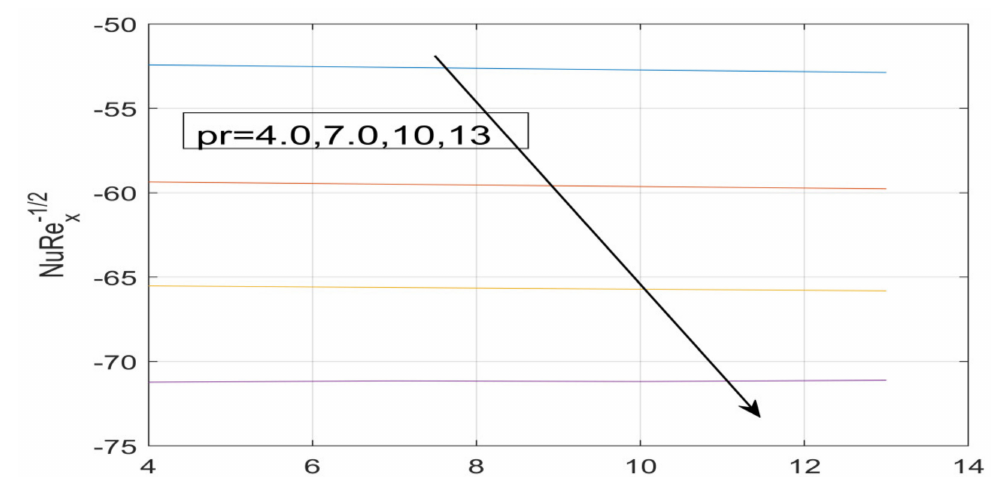
Figure 24. Variation in γ _1 on gˆ (cid:48) (0).